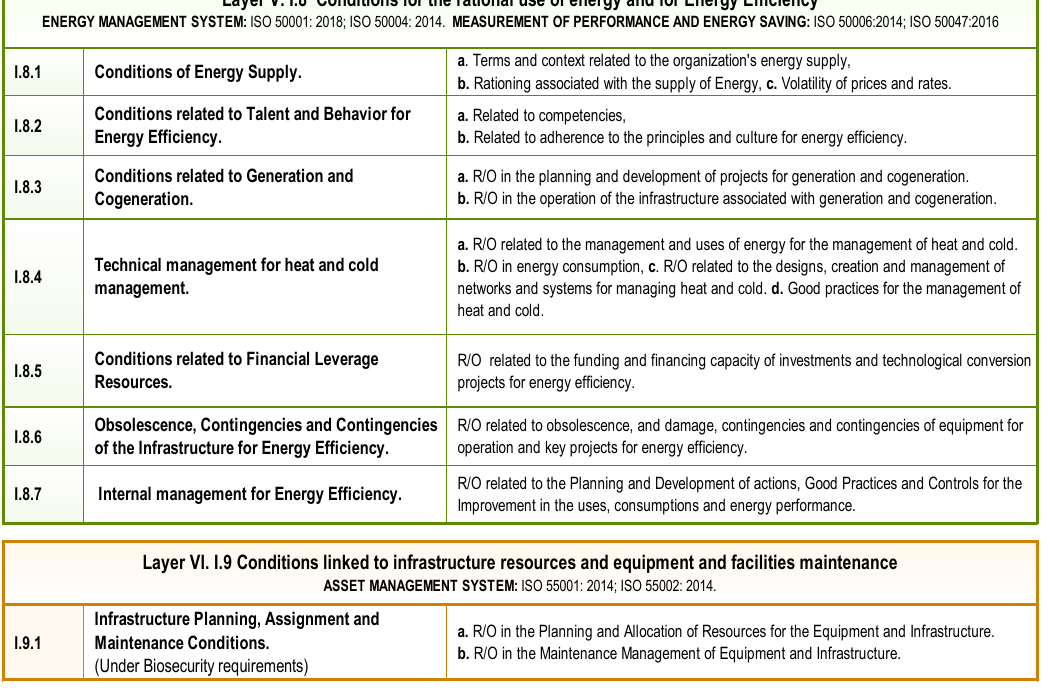
/ O. Layer V: I.8, and Layer